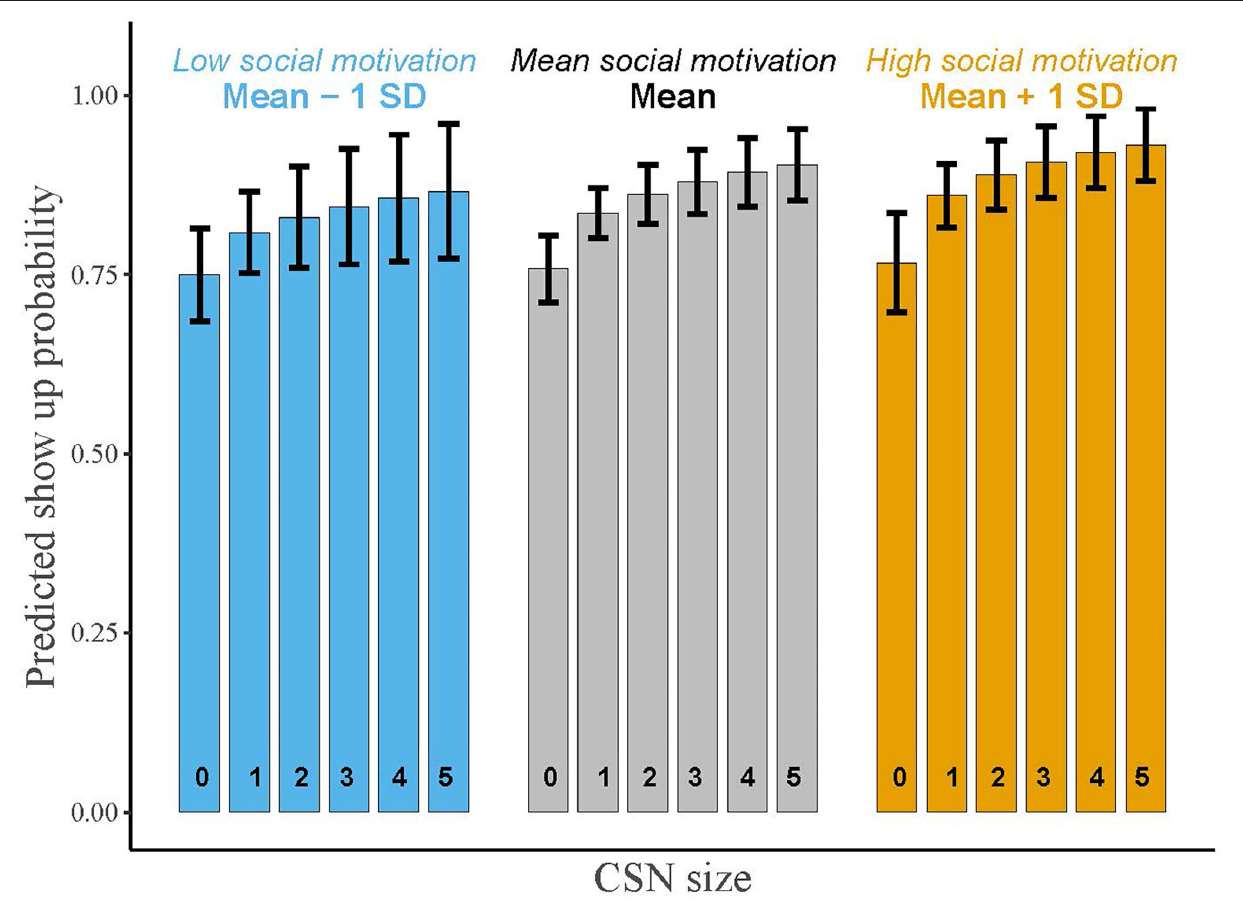
FIGURE 3 | Predicted probabilities of showing up at a running event, moderated by social motivation. Bars reflect predicted probabilities of showing up at the Seven Hills Run, conditional on social motivation (mean 1 SD, mean, mean 1 SD), with error bars reflecting 95% confidence intervals. X-axis labels refer to the number of − + important co-runners in W2. Probabilities are based on estimates in Table 3 (model